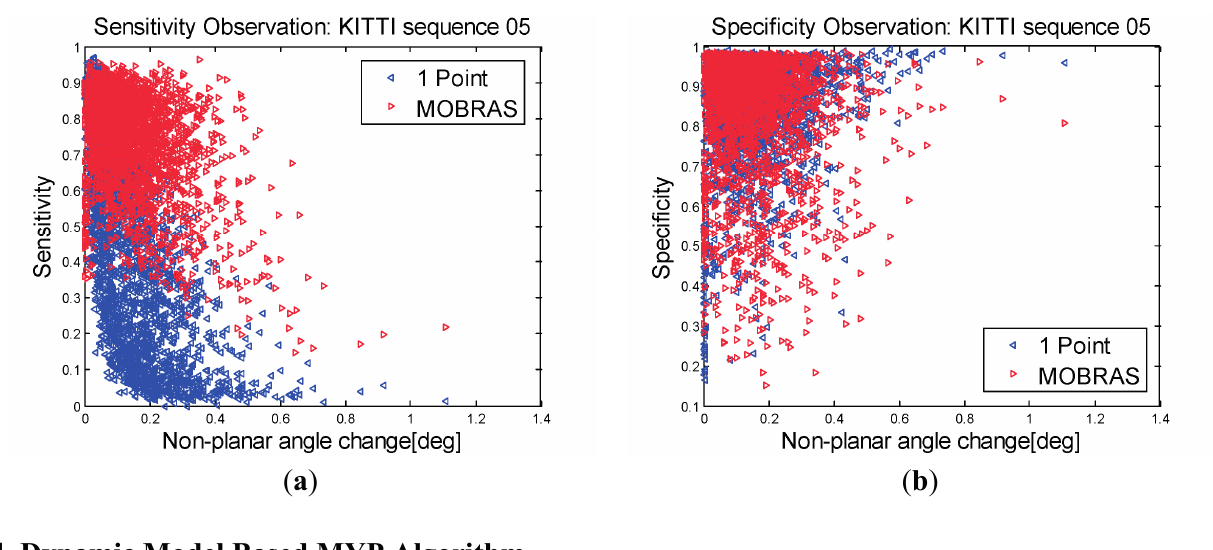
Figure 6. Sensitivity and Specificity. Comparison between 1-Point and MOBRAS